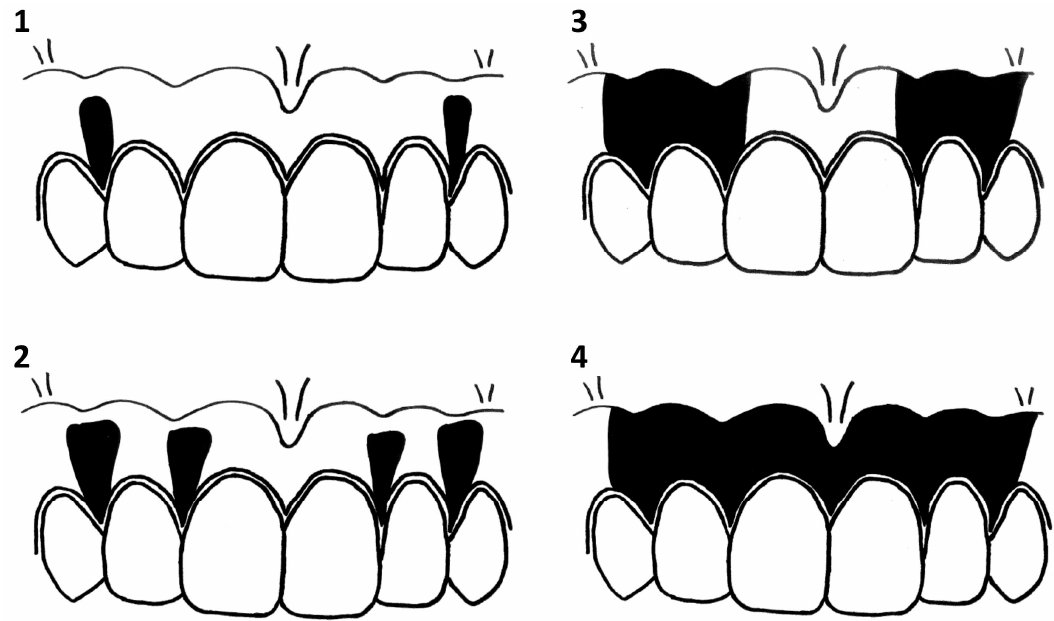
Figure 2. Degrees of gingival pigmentation (Hedin’s classification). ( 1 ) A baseline was drawn horizontally on the maxillary gingiva at the crown length of the maxillary right lateral incisor. ( 2 ) Between the right and left maxillary canines, a vertical line was drawn from the baseline to the cervical line of each tooth. ( 3 ) Nine points were plotted to separate eight equal parts on the vertical line, and it was adopted that measuring sites were the points in the attached gingiva, and the vertical lines were placed at mesial and central and distal points of the frontal teeth. ( 4 ) The presence of pigmentation at the measuring sites was evaluated and the percentile with pigmentation was calculated for the gingival melanosis record (GMR).